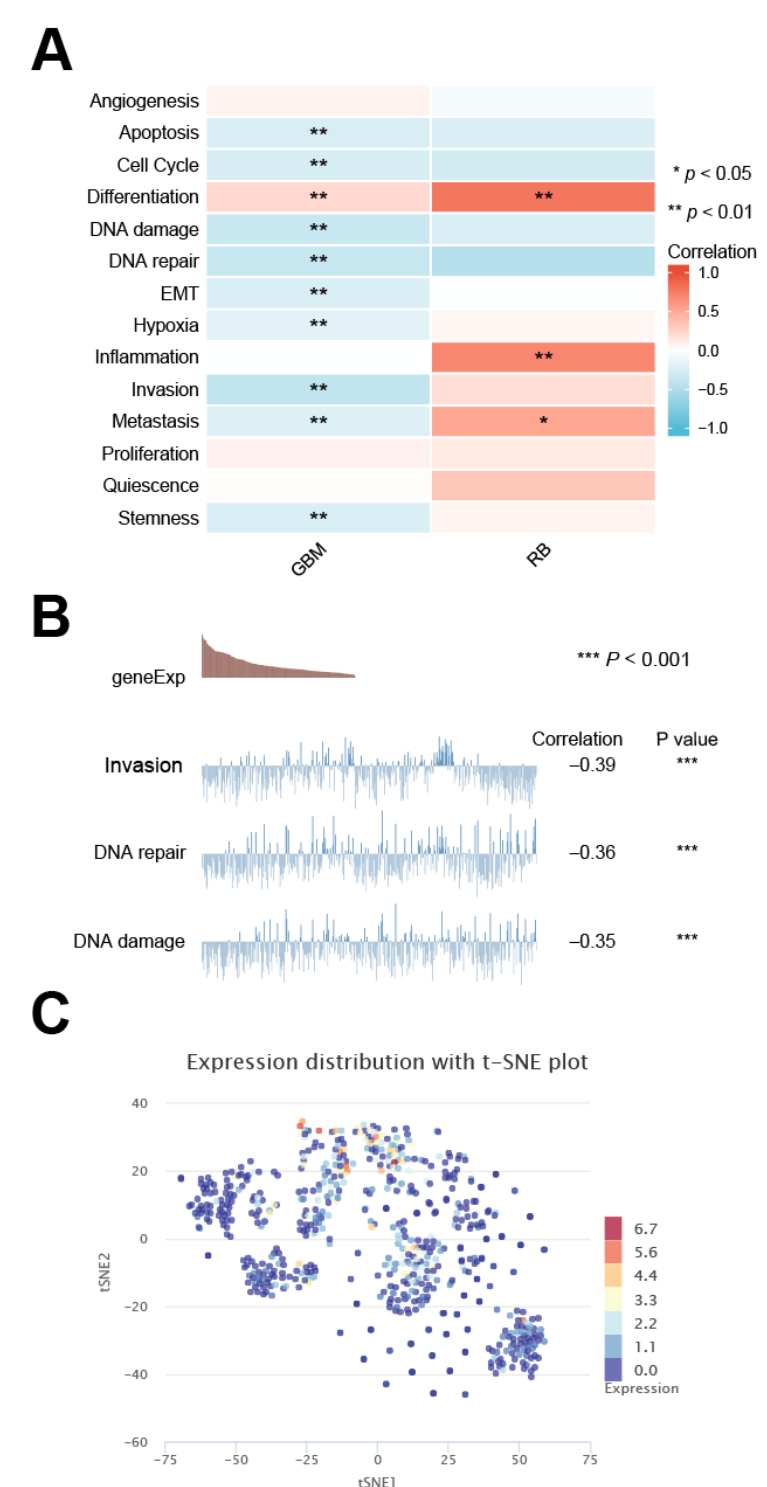
Figure 10. Single cell sequencing of DMRT3 and its relationship to the tumor functional status. ( A ) DMRT3 expression, compared with different tumor functional status, based on the CancerSEA database ( B ) Correlation between the DMRT3 expression, based on the CancerSEA database and three significantly different functional statuses. ( C ) T-SNE plots showing the DMRT3 expression profiles in the single cells of the GBM